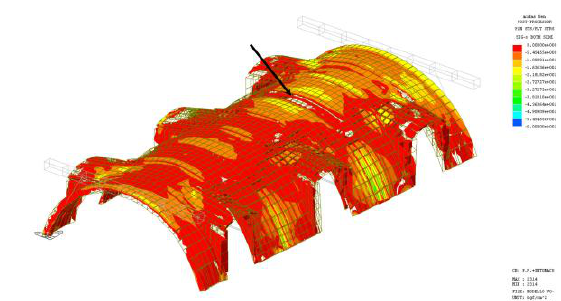
Figure 20b. Compression at the extrados after consolidation